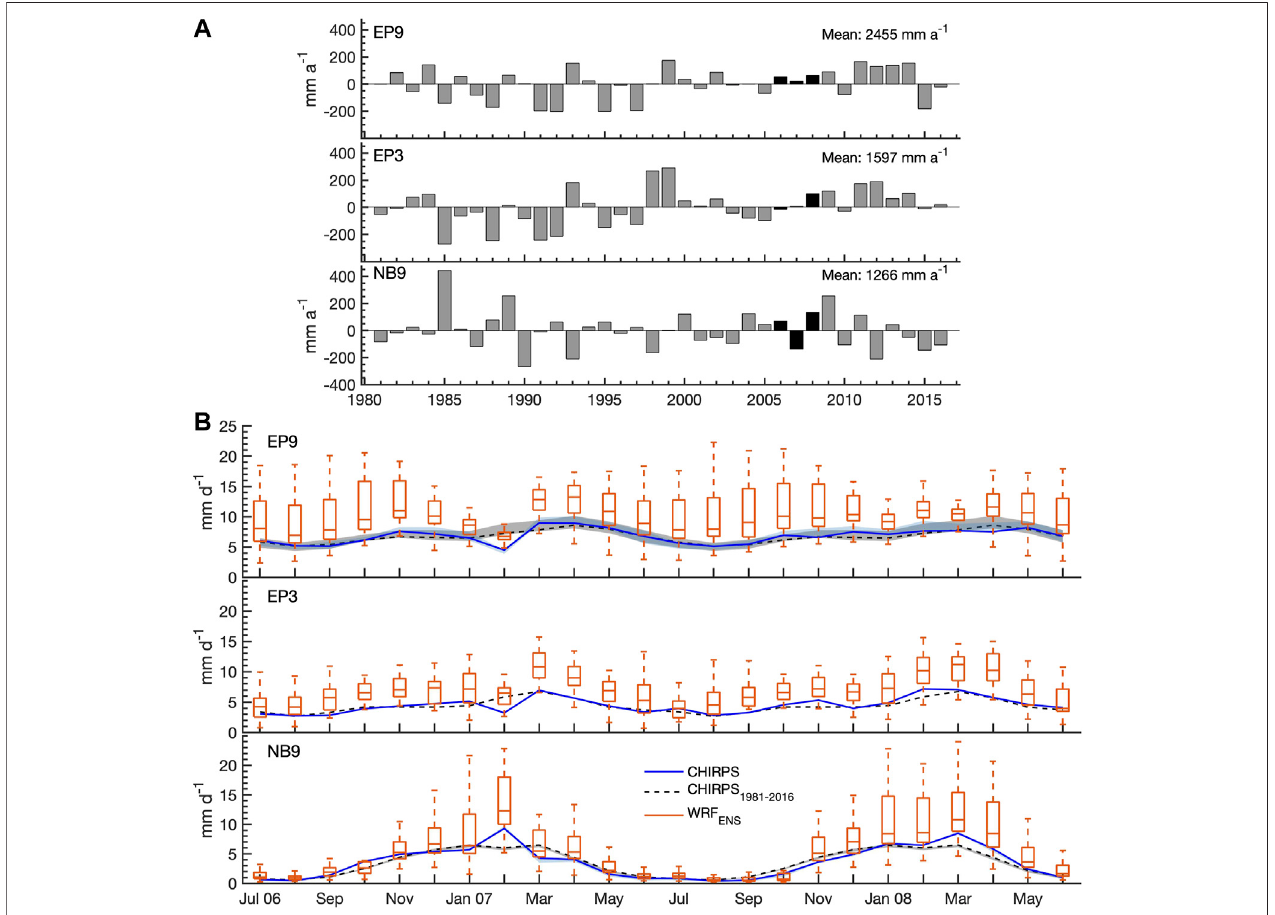
FIGURE 2 | (A) Annual domain-averaged precipitation anomalies (mm a − 1 ) of CHIRPS for EP9 (upper) , EP3 (middle) and NB9 (lower) with respect to the climatological mean from 1981 to 2016. Simulated years of 2006 – 2008 are marked with black. (B) CHIRPS timeseries and 1981 – 2016 climatology, together with WRF ensemble uncertainty of monthly domain-averaged precipitation (mm d − 1 ) for Jul 2006 till Jun 2008 for EP9 (upper) , EP3 (middle ) and NB9 (lower) . The uncertainty in the reference data by including MSWEP and ERA5-Land for EP9 and NB9 is depicted by shaded areas.